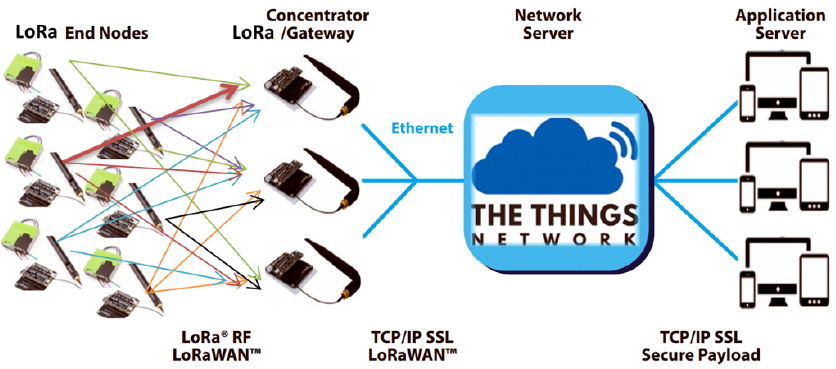
Figure 5. LPWAN LoRa utilized architecture and network topology.